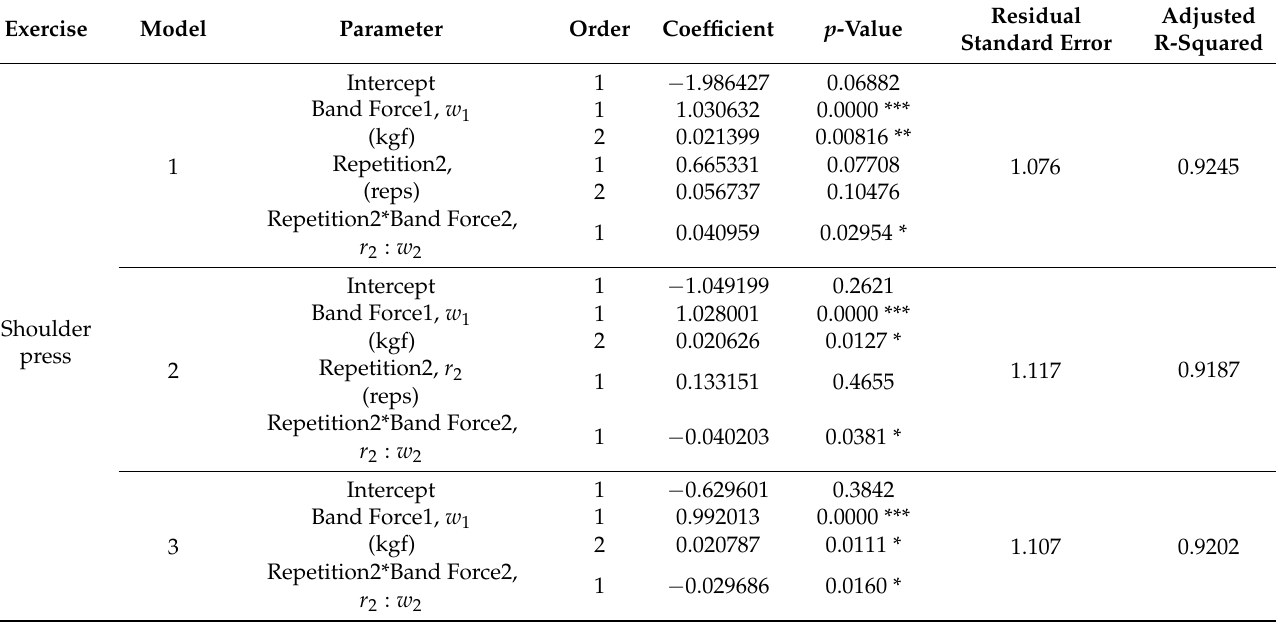
Table A2. Shoulder press 1 − RM equations and model